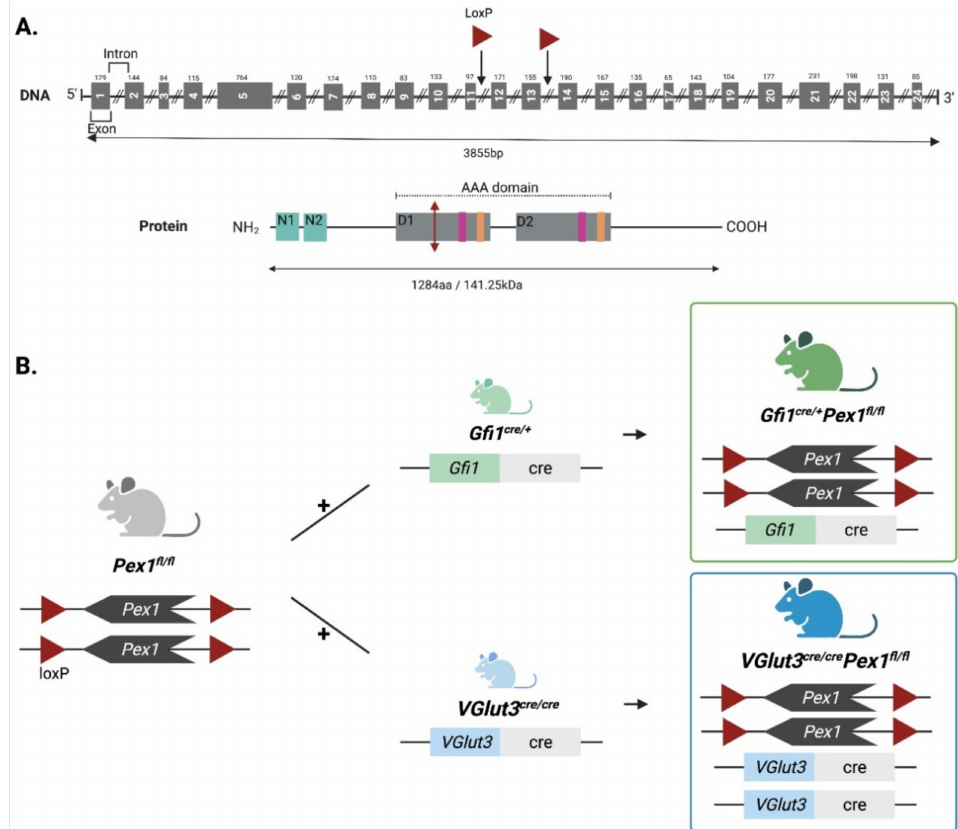
Figure 1. Generation of new organ specific Pex1 knockout mice. ( A ) Schematic of Pex1 gene and Pex1 protein. LoxP sites (red triangle) were inserted inside the introns 11 and 13 of the Pex1 gene. Excision of exons 12 and 13, upon Cre recombination, leads to the production of a truncated protein (red vertical arrow). The Pex1 protein is composed of two N-terminal domains (N1 and N2) and two functional AAA domains (D1 and D2). The conserved Walker motifs domains into AAA domains are indicated (Walker A motifs: magenta and Walker B motifs: orange); ( B ) Breeding scheme for generating Gfi1 cre/+ Pex1 fl/fl mice line ( Cre expressed in inner and outer hair cells around E15.5) and VGlut3 cre/cre Pex1 fl/fl mouse line ( Cre expressed in inner hair cells around birth). Pex1 fl/fl mice were used as a control. Created with BioRender.com (Accessed date: 6 December